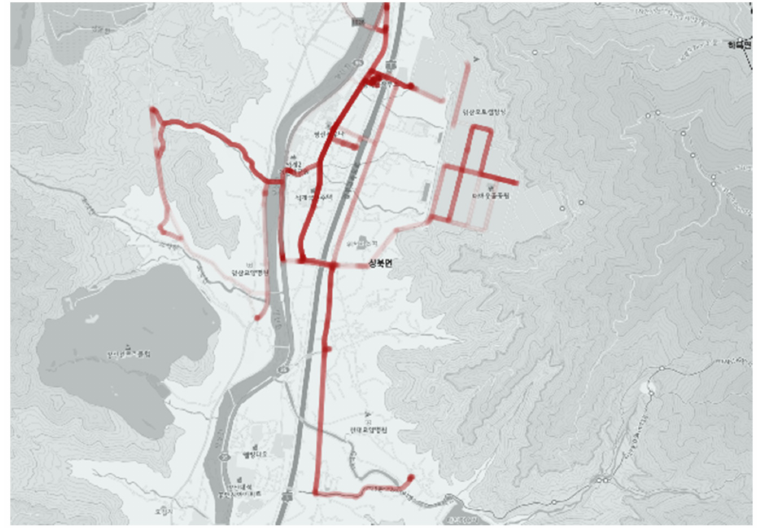
Figure 22. Actual driving record of city-type bus No.